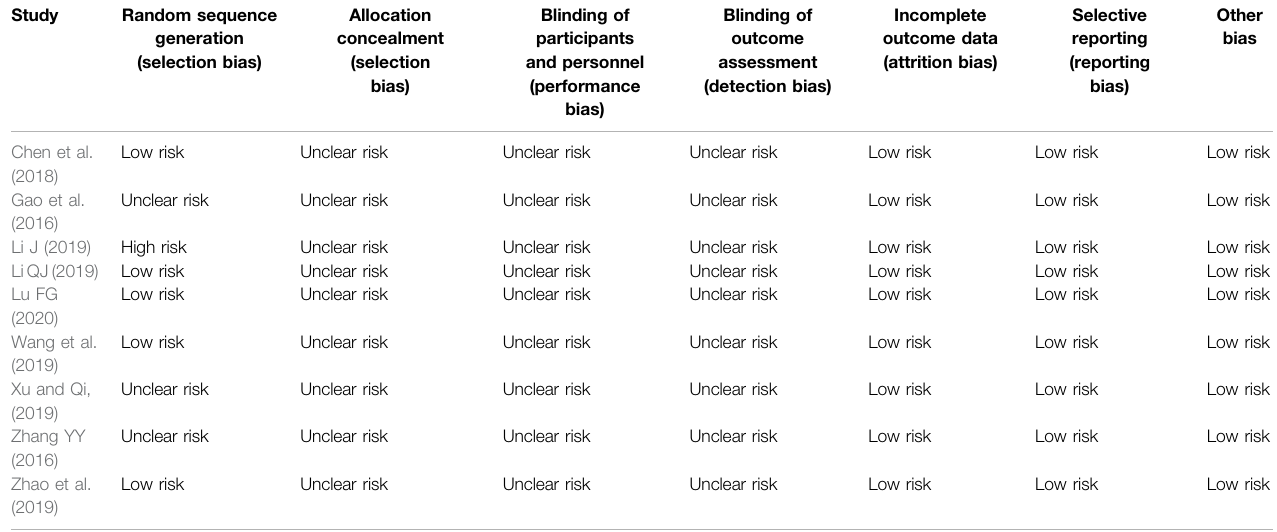
TABLE 2 | Risk of bias of included